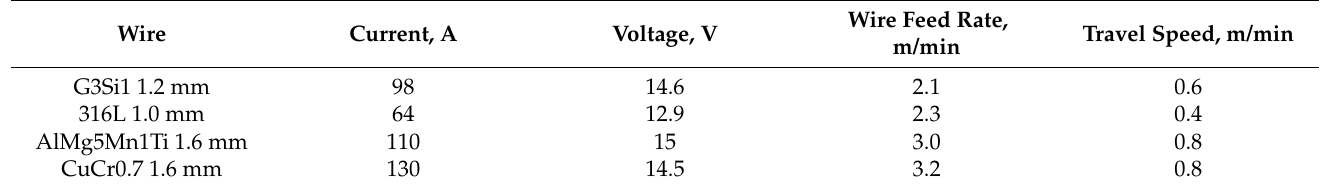
Table 3. Welding parameters for the multilayer CMT-standard weld